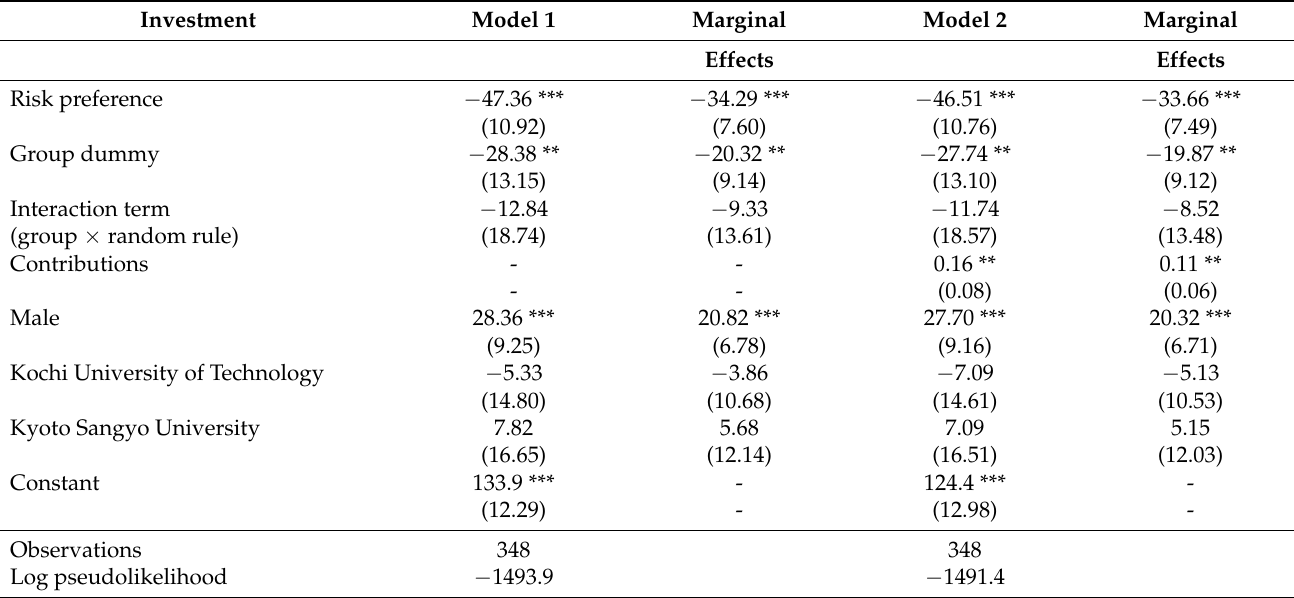
Table 5. Estimation results: Investment (Tobit